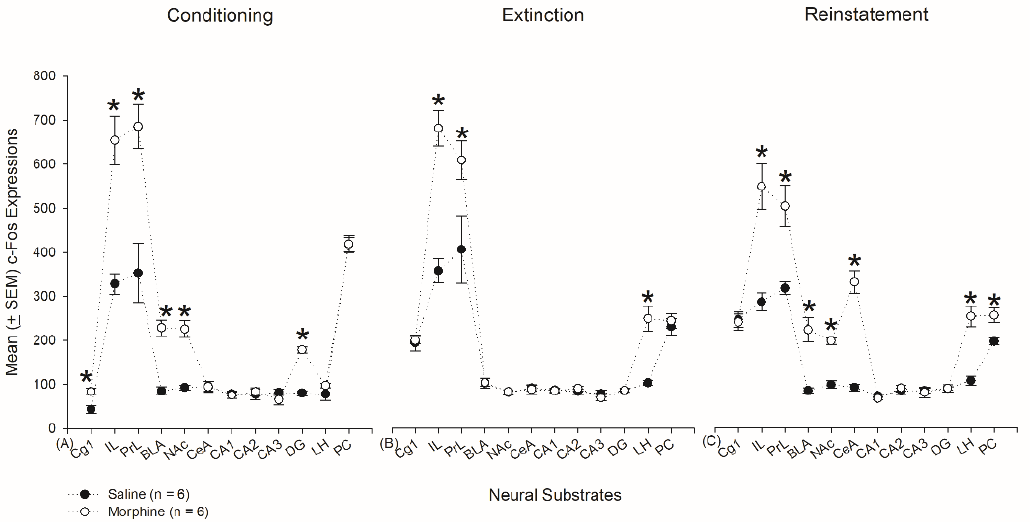
Figure 18. Assessing homeostasis analysis with c-Fos expression for the cingulate cortex area 1 (Cg1), the prelimbic cortex (PrL), the infralimbic cortex (IL), the basolateral amygdala (BLA), the nucleus accumbens (NAc), the central amygdala (CeA), the CA1, the CA2, the CA3, the dentate gyrus (DG), the lateral hypothalamus (LH), and the piriform cortex (PC) in the three phases: ( A ) conditioning, ( B ) extinction, and ( C ) reinstatement. * p < 0.05 when comparing the saline and morphine groups ( n = 6 per group).